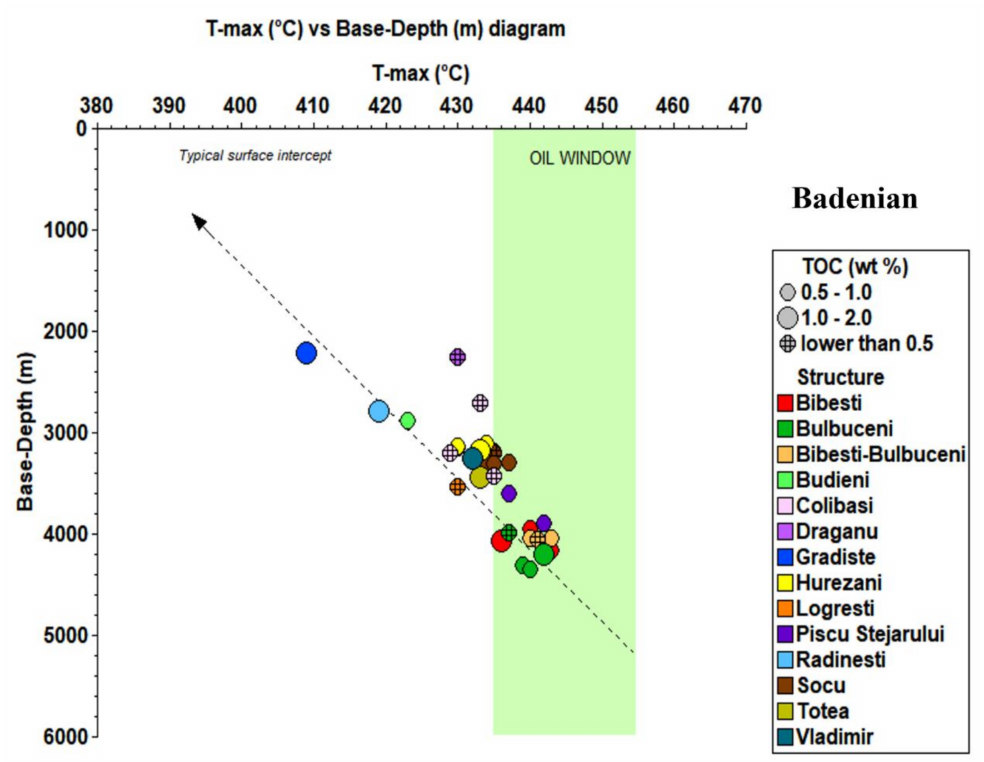
Figure 11. T max ( ◦ C) vs. depth (m) diagram, showing the thermal maturity of the Upper Badenian source rocks from the central-southern part of the Getic